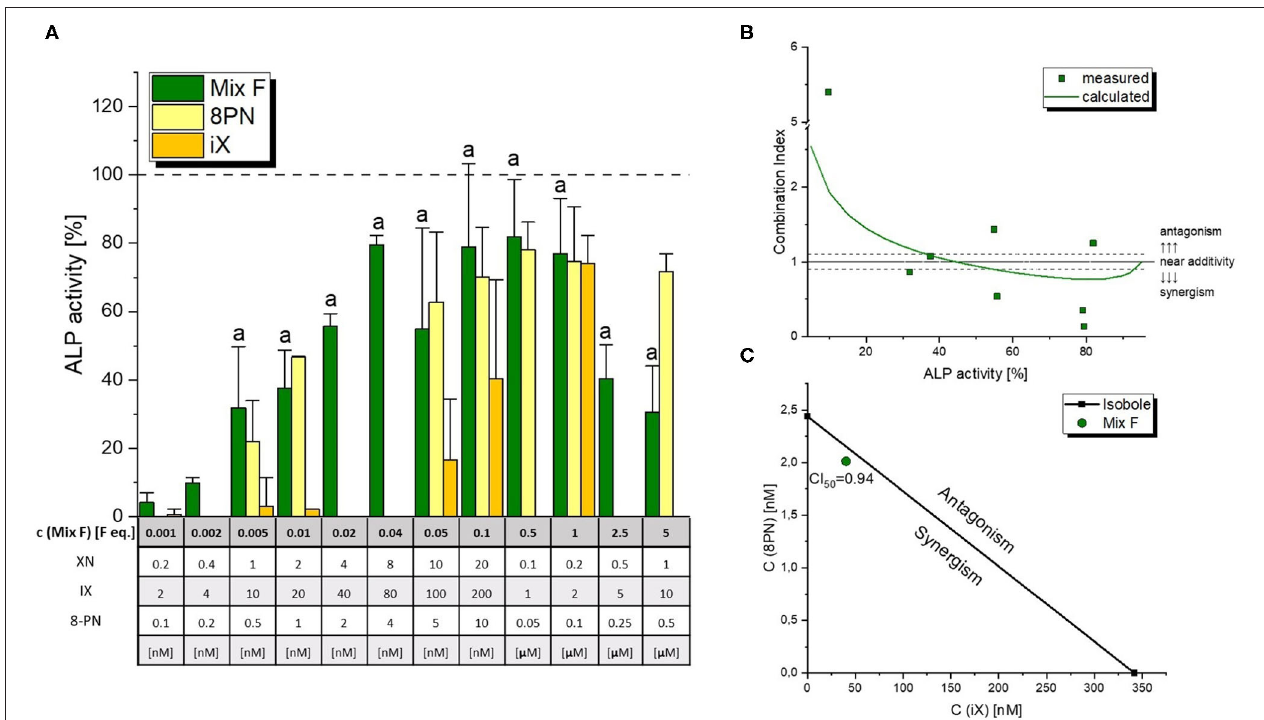
FIGURE 4 | Estrogen receptor dependent induction of ALP expression by a polyphenol mixture. Graph (A) depicts ALP assay results for the flavonoid mixture in comparison to contained concentrations of the active constituents 8-prenylnaringenin (8PN) and isoxanthohumol (iX). Values were scaled to the solvent control (0%) and the positive control (1nM E2, 100%) and are expressed as means ± SD of at least four independent experiments. Significant differences to the solvent control were calculated by one-way ANOVA, followed by Fisher LSD post-hoc testing, and are indicated by “a” ( p < 0.05). The effect-CI plot in graph (B) shows the dependency of the combination index on estrogenicity levels, with the line indicating the calculated CI based on the whole dose-response curves and squares representing CI values calculated for actually measured data points. The isobologram in graph (C) depicts the strenght of interaction at ED 50